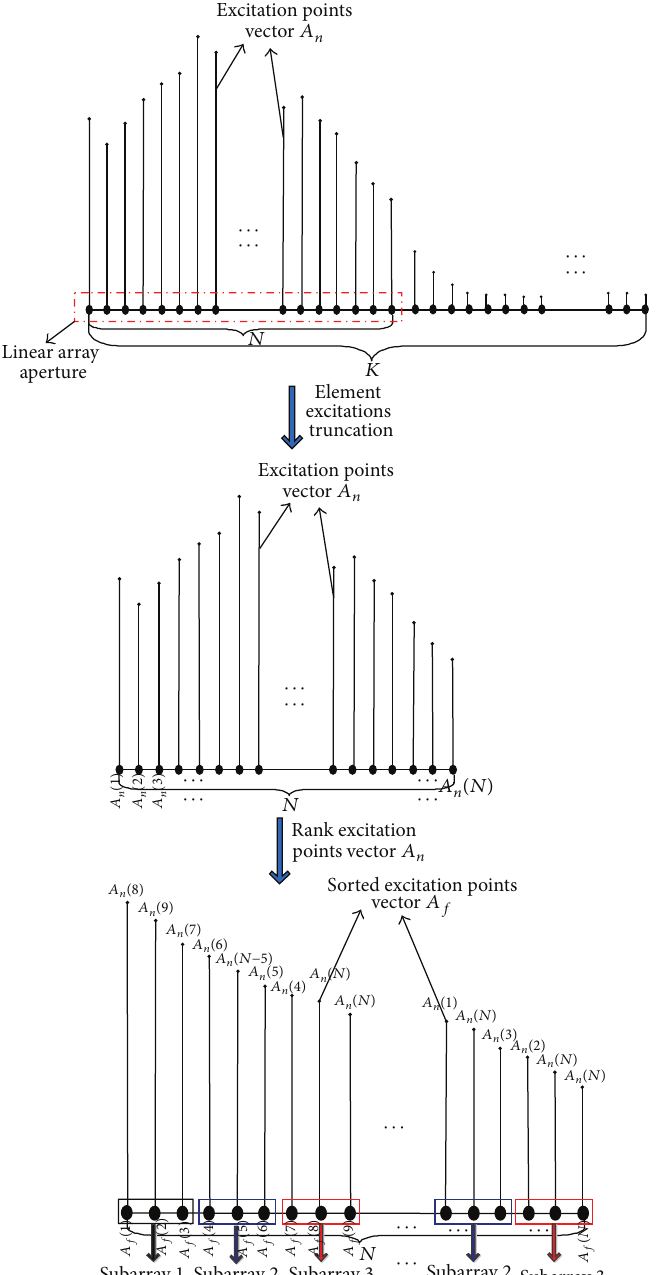
Figure 2: The schematic diagram of the element excitations selecting process for the interleaved subarrays ( 𝑇 = 3 ).